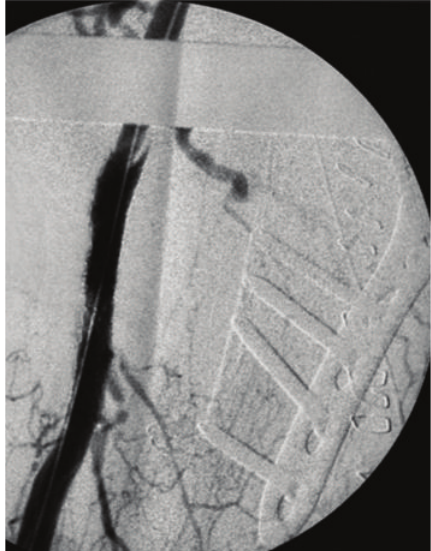
Figure 5: Restored vessel patency after stenting the axillary artery.